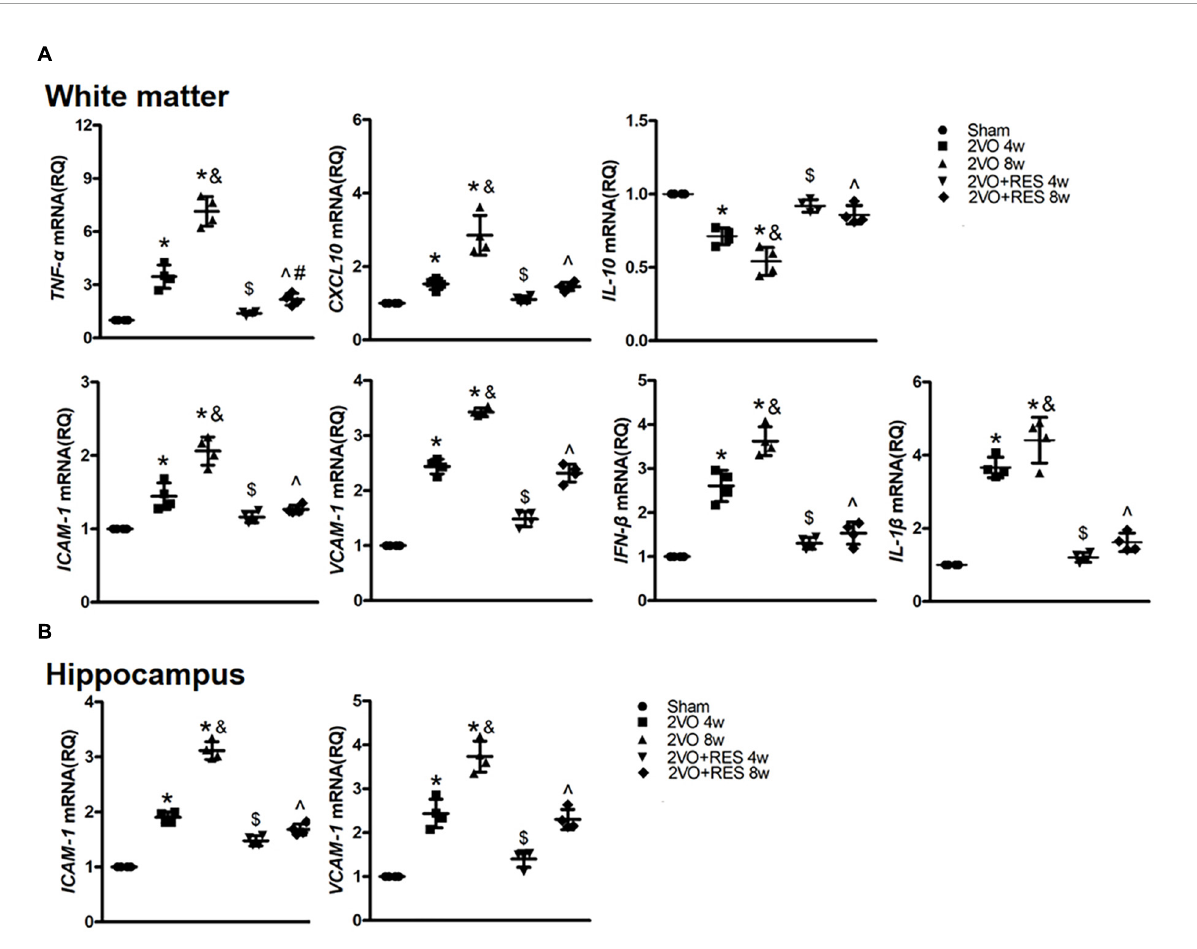
FIGURE4 The expression of pro- and anti-inflammatory genes. (A) Quantification of mRNA levels of TNF- α , CXCL10, IL-10, ICAM-1, VCAM-1, IFN- β , and IL-1 β in white matter tissues. GAPDH was used as an internal control ( n = 4 per group). (B) Quantification of mRNA levels of ICAM-1 and VCAM-1 in hippocampus tissues. GAPDH was used as an internal control ( n = 4 per group). * p < 0.05 vs. Sham; & p < 0.05, 2VO 8w group vs. 2VO 4w group; # p < 0.05, 2VO + RES 8w group vs. 2VO + RES 4w group; $ p < 0.05, 2VO + RES 4w group vs. 2VO 4w group; ˆ p < 0.05, 2VO + RES 8w group vs. 2VO 8w group. Data are presented as mean ±